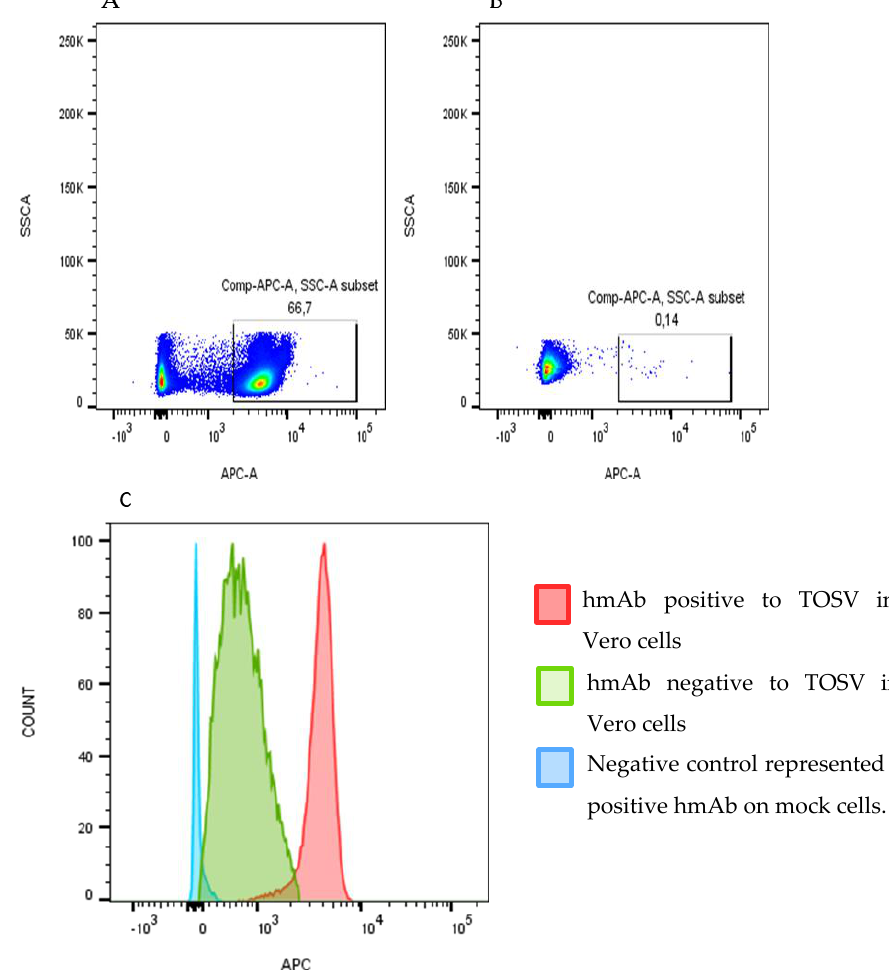
Figure 2. High-throughput FACS analysis using TOSV-infected VERO cells. ( A ) shows the identification of TOSV-positive human mAb by using an anti-hFc-APC secondary antibody (BD Biosciences) reacted with infected cells, while ( B ) shows a TOSV-negative hmAb. ( C ) shows the difference between the fluorescence of a positive and a negative hmAb to TOSV-infected Vero cells versus mock cells. Based on this primary screening, 112 mAbs which were positively reactive against Table 2. Human mAbs tested for neutralizing activity against TOSV. TOSV infected cells were selected. Among them, 7 antibodies were derived from PBMCs